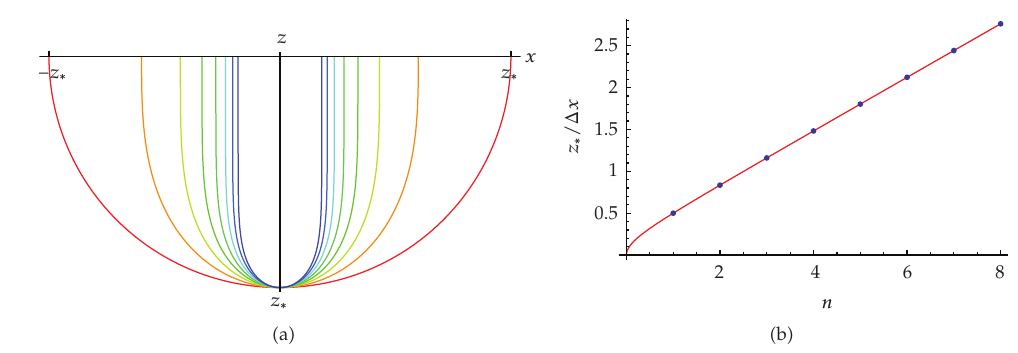
Figure 10: (cid:3) a (cid:4) Cross-section of n -dimensional minimal surfaces in Poincare AdS d (cid:9) 1 , with varying dimensionality n (cid:7) 1 , 2 ,..., 8: the outermost (cid:3) red (cid:4) curve corresponds to n (cid:7) 1 while the innermost (cid:3) purple (cid:4) curve to n (cid:7) 8. Note that d (cid:3) as long as it is high enough to accommodate the surface (cid:4) does not enter. (cid:3) b (cid:4) Corresponding ratio of maximal bulk radial extent z ∗ to its boundary size Δ x